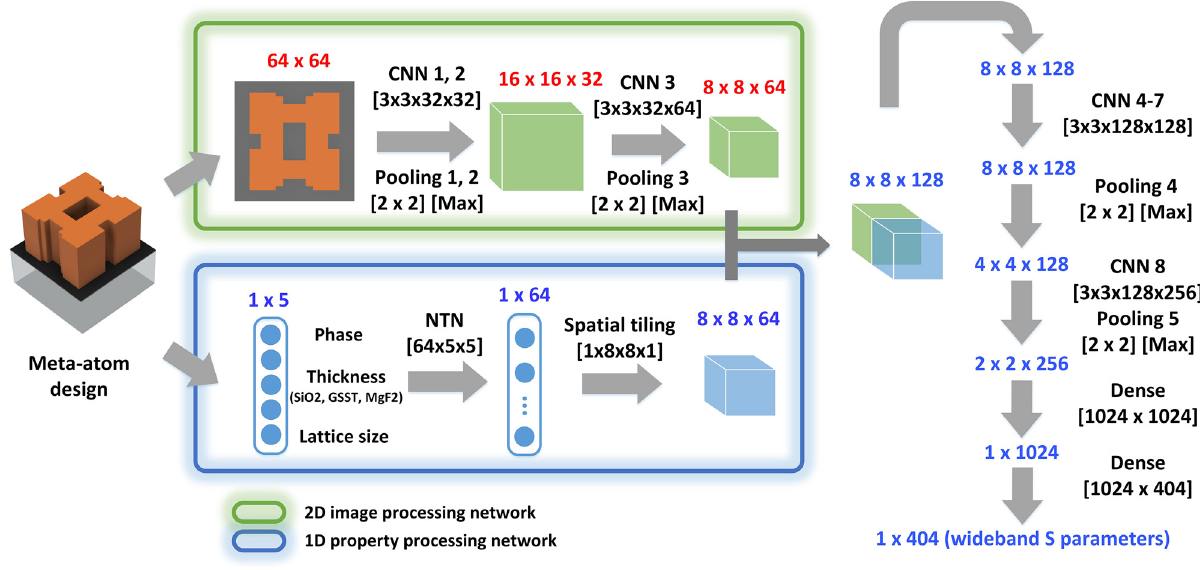
Figure 2: Network architecture. The meta-atom design parameters were evaluated using a 2-D image processing network (circled in green) and a 1-D property processing network (circled in blue). After processing with several convolutional layers and dense layers, the S -matrix (real and imaginary part) of the meta-atom over the spectrum of 60–100 THz were generated as the final output. 101 frequency points, with a spacing of 0.04 THz, were used to represent the full spectra for each S